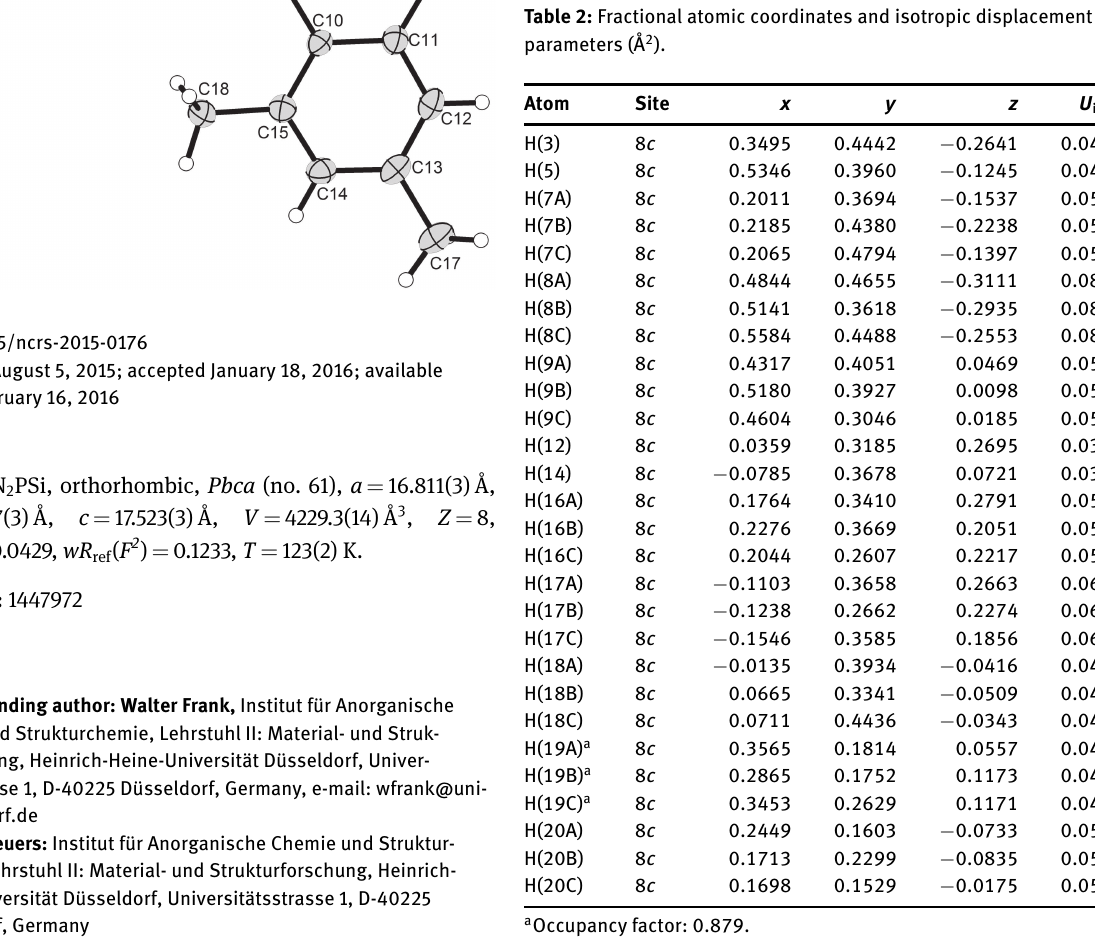
Table 2: Fractional atomic coordinates and isotropic